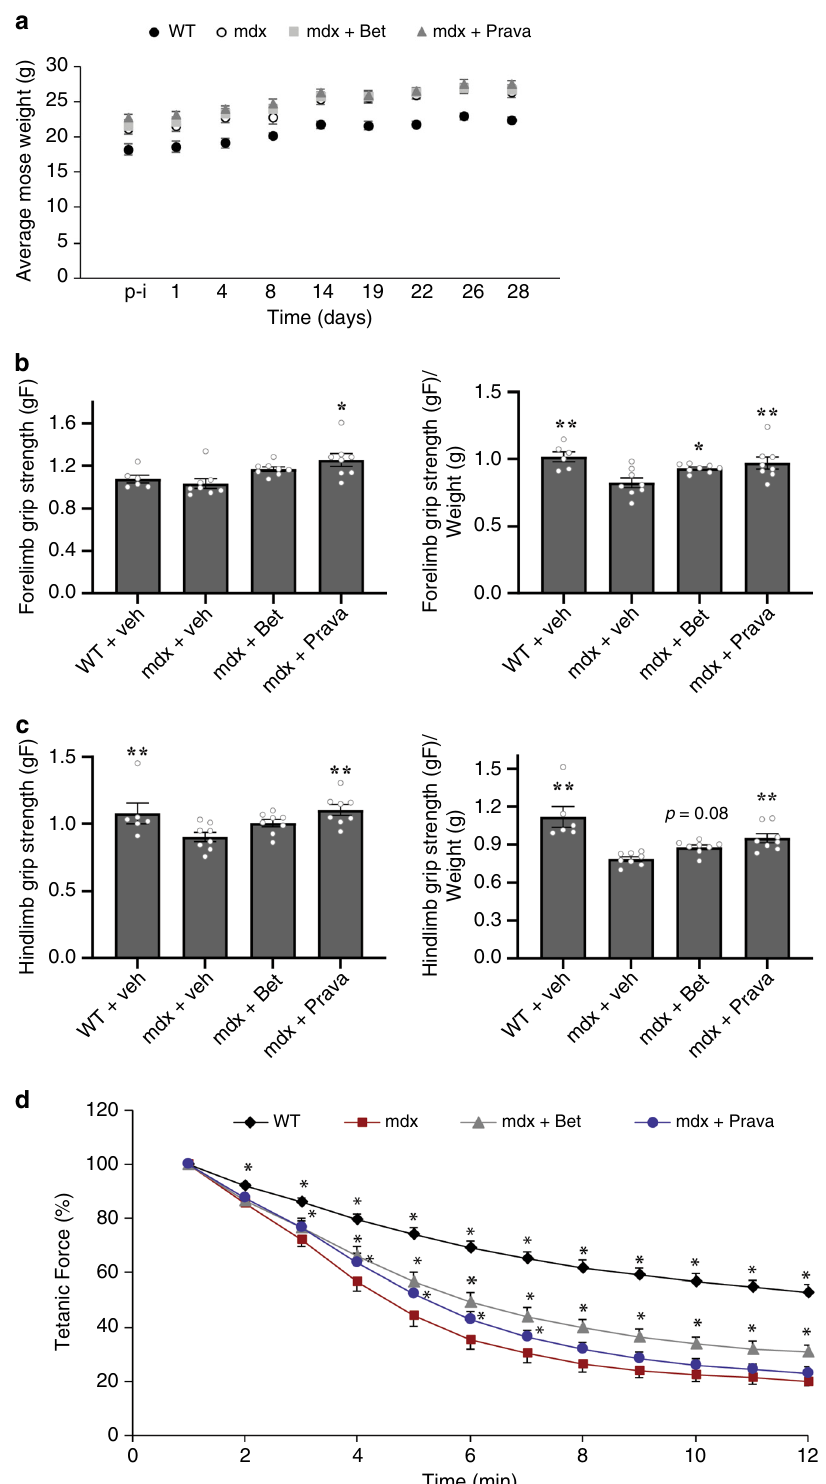
Fig. 4 The effects of Betaxolol and Pravastatin treatment on muscle strength of mdx mice. Mdx mice were treated with Betaxolol (Bet), Pravastatin (Prava) or vehicle for 4 weeks. a mdx and wild-type (WT) mouse body weight (g). b Forelimb and c Hindlimb grip strength analysis of WT, vehicle-treated, Bet- or Prava-treated mdx mice normalized or not normalized to body weight. N = 6 for WT and N = 8 for mdx + veh or treated, error bars represent SEM. * P < 0.05, ** P < 0.01 vs vehicle treated mdx mice. One-way ANOVA and Bonferroni post-hoc test was performed to determine statistical differences for ( a – c ). A split-plot ANOVA was used for force drop analysis ( d ). Source data are provided as a Source Data fi